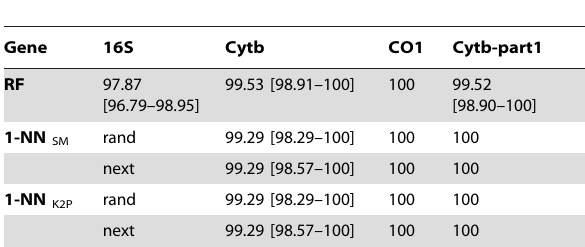
Table 2. Success rates (%) obtained by performing the two assignment methods (RF and 1 -NN) with the three genes (16S, Cytb, CO1) and the first part of the Cytb gene.